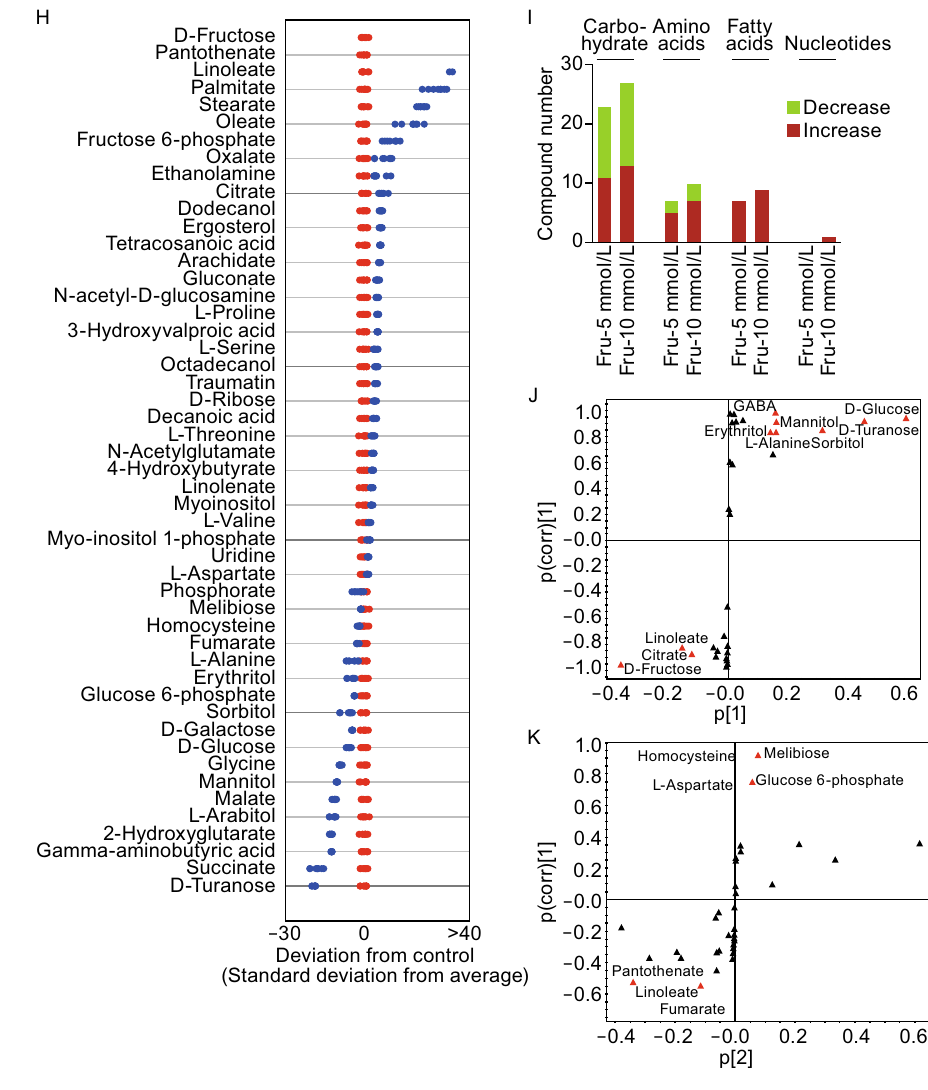
were of high quality. Further, clear separation was obtained in PCA (two components, R2X = 0.983, R2Y = 0.969, Q2 = 0.956) scores plots derived from the GC-MS